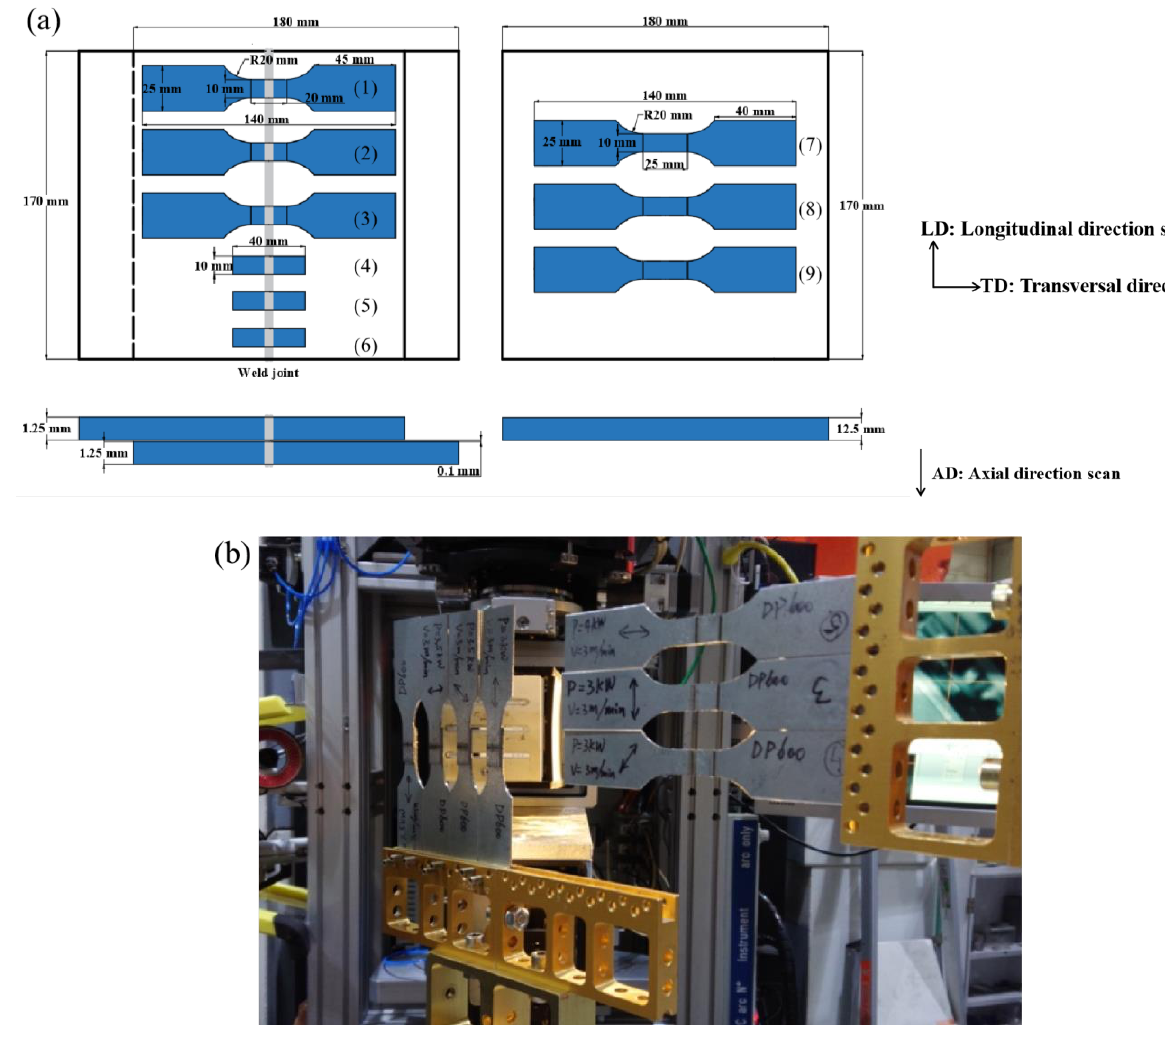
Figure 5. ( a ) Dimensions for the specimens, ( b ) schematic of the experiment.